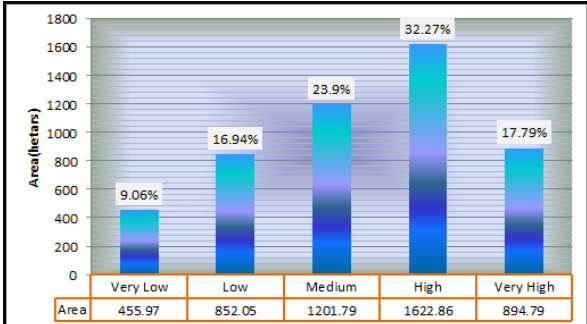
Figure7. Histogram of calculated landslide susceptibility map showing the relative areas for each susceptibility class ((susceptibility classes are labelled with the percent of total area